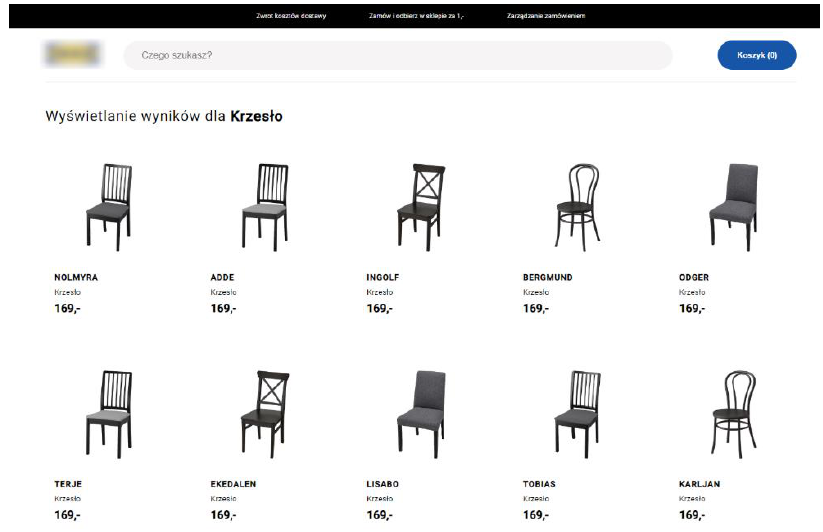
Figure 2. Test store appearance—category page. Source: own elaboration.